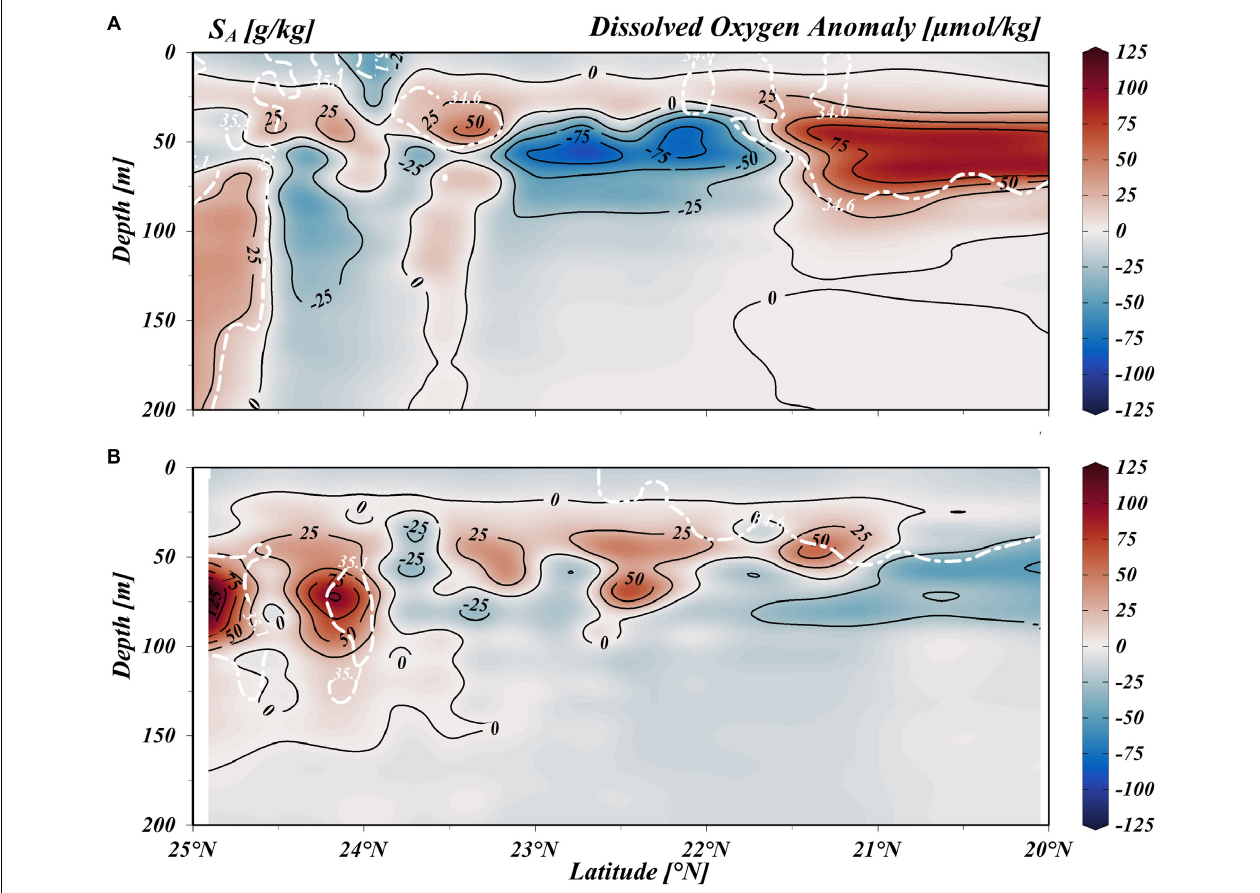
FIGURE 6 | Vertical distribution of dissolved oxygen (DO, µ mol/kg) anomalies and absolute salinity (S A , g/kg) along transect 1 (see Figure 1 ). (A) June 2015, (B) March 2016. Isohaline limits for Tropical Surface Water and Californian Current Water ( < 34.6 g/kg) and Gulf of California Water ( > 35.1 g/kg) appear in white. Refer to text for anomaly